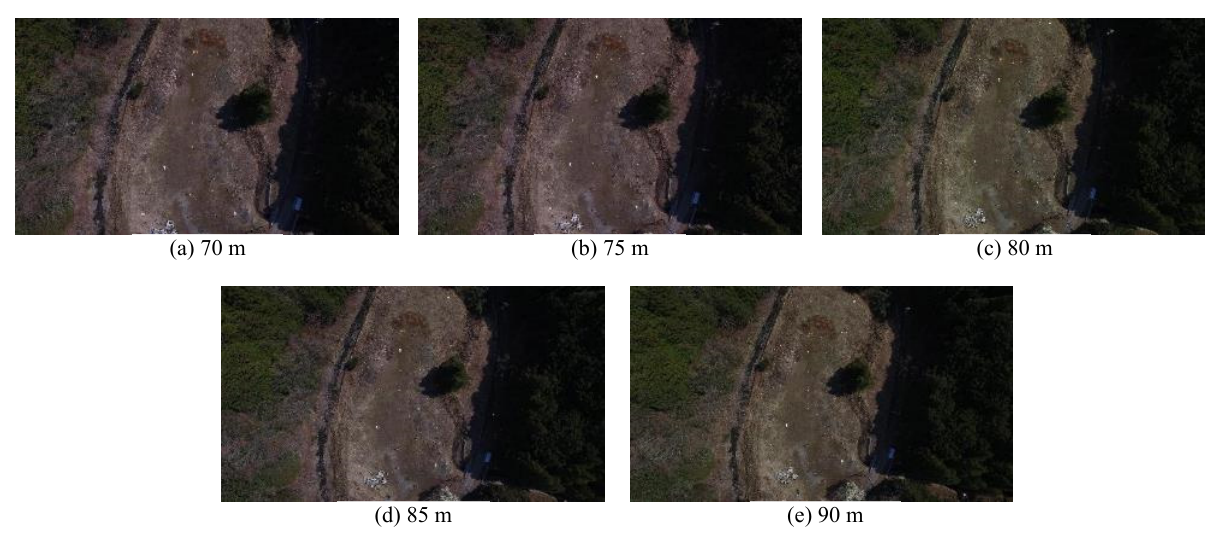
Figure 8. Vertical images for checking